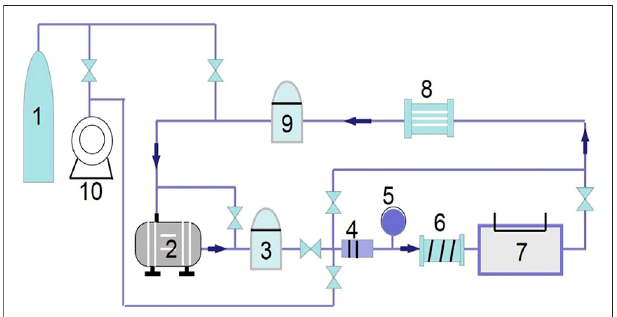
FIGURE 1 | Schematic diagram of experimental apparatus: 1) gas cylinder;2)compressor;3)deliverysurgetank;4) fi lter;5)turbine fl